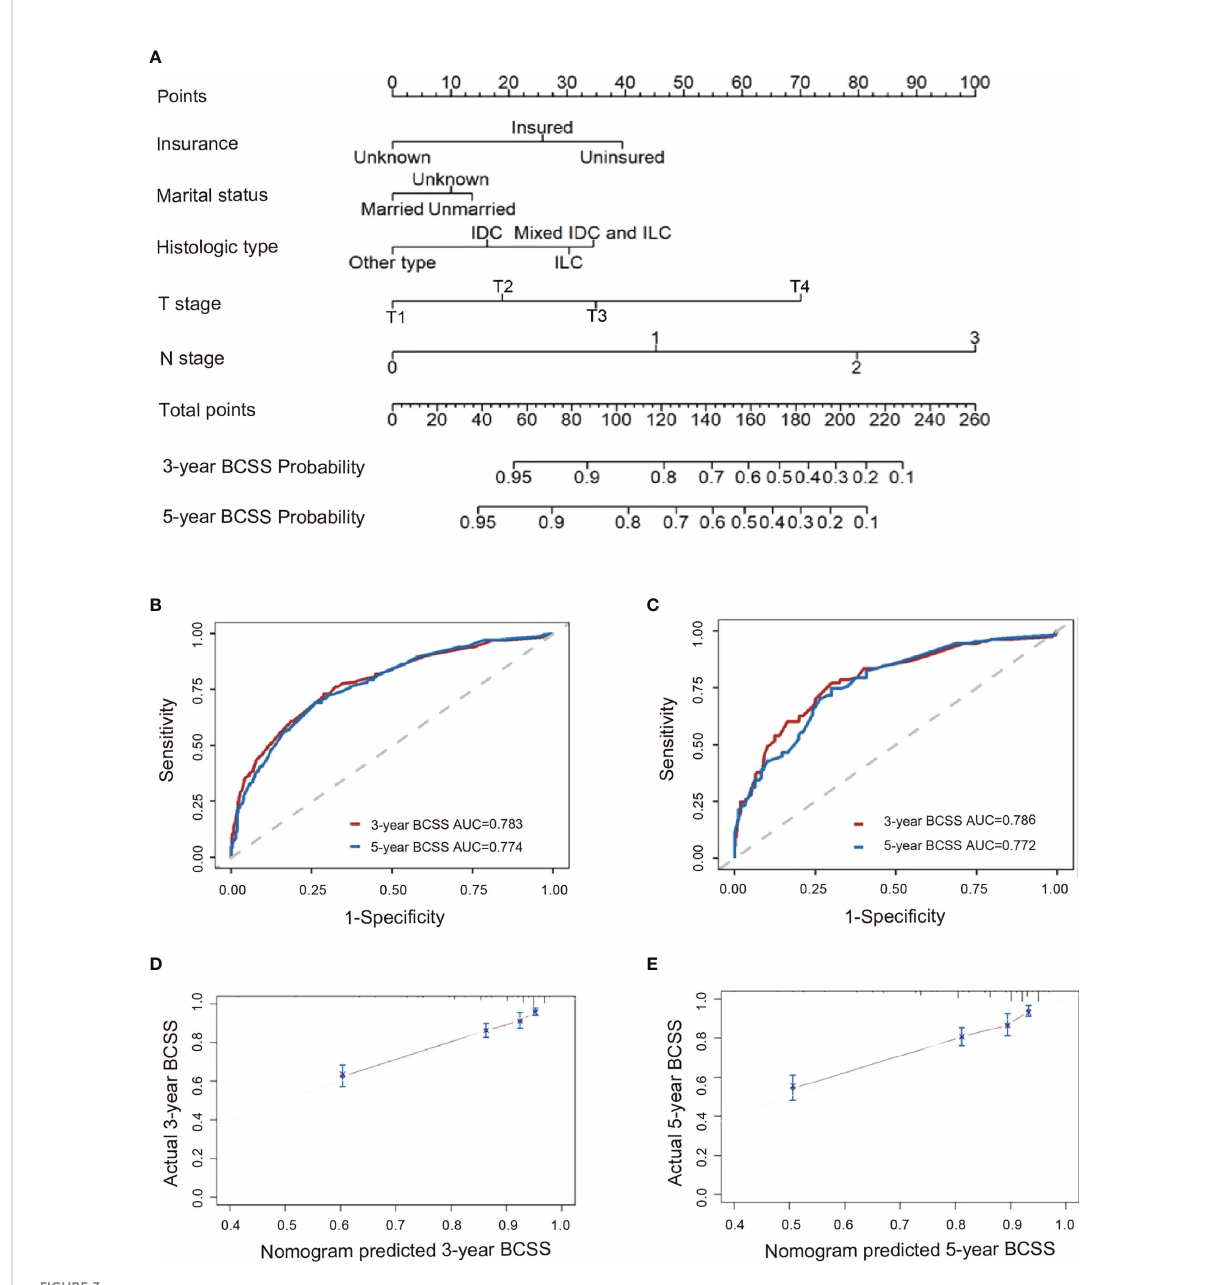
FIGURE 3 Analysis of factors predictive of BCSS among patients <40 years with triple-negative breast cancer. (A) Nomogram for predicting 3-year and 5- year BCSS. Also shown are ROC curves for the (B) training set and (C) validation set, as well as the nomogram ’ s calibration curves in terms of (D) 3-year BCSS and (E) 5-year BCSS. AUC, area under the curve; BCSS, breast cancer-speci fi c survival; ROC, receiver operating